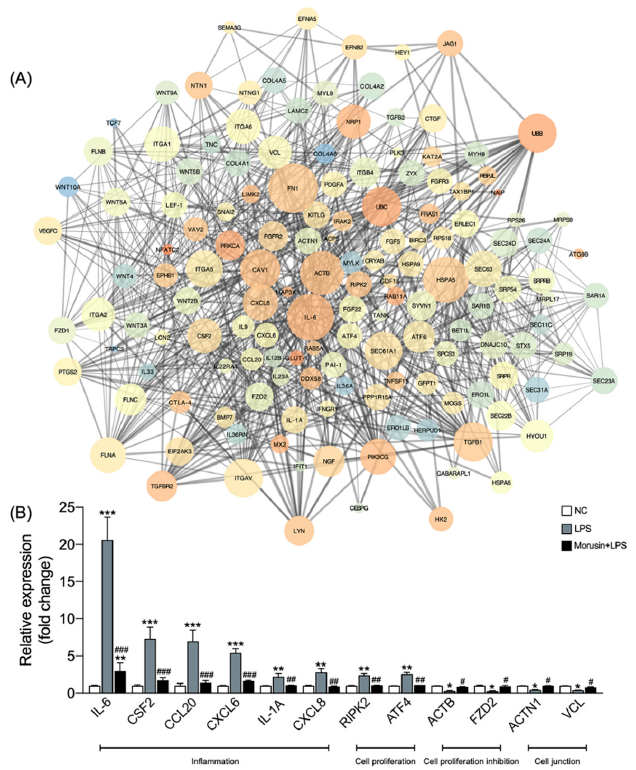
Figure 5. Effects of Morusin on the expression profile of hub genes in ruminal epithelial cells (RECs) with different treatments. ( A ) Protein–protein interaction (PPI) analysis of the overlapping differ- entially expressed genes (DEGs, p adj < 0.05 and fold change > 2) that were downregulated in the Morusin+LPS group compared with LPS group and upregulated in the LPS group compared with NC group, as well as upregulated in the Morusin+LPS group compared with LPS group and down- regulated in the LPS group compared with NC group. The node color represents the clustering co- efficient (low values are blue, and high values are red), and the node size is proportional to the number of degrees. The edge represents the interaction (the thicker edge indicates the lower be- tweenness). ( B ) Expression of representative hub genes related to inflammation, cell proliferation, cell proliferation inhibition, and cell junction in ruminal epithelial cells (RECs) among different groups. RECs were treated without (NC, n = 4) or with 0.1 µg/mL lipopolysaccharide for 3 h after pretreating with 50 µg/mL of Morusin for 12 h (Morusin+LPS, n = 4) or not (LPS, n = 4). Data repre- sent mean ± SEM. * p < 0.05, ** p < 0.01, *** p < 0.001 vs. NC; # p < 0.05, ## p < 0.01, ### p < 0.001 vs. LPS. 2.5. Morusin Inhibited the Activation of AKT and NF- κ B Signaling in RECs upon LPS Stimulation AKT and NF- κ B signaling are known to be key regulators in LPS-induced inflamma- tory responses and abnormal cell proliferation. Therefore, we examined whether Morusin regulated LPS-induced phosphorylation (p) of AKT, I κ B α , and NF- κ B p65 in RECs using immunoblotting. The results showed that the LPS stimulation significantly upregulated the protein expression levels of p-AKT/AKT ( p < 0.05), p-I κ B α /I κ B α ( p < 0.01), and p- p65/p65 ( p < 0.05), while it downregulated the protein expression of I κ B α / β -actin ( p < 0.05) in RECs compared with the negative control. However, the pretreatment of Morusin sig- nificantly downregulated the protein expression levels of p-AKT/AKT ( p < 0.05), p- I κ B α /I κ B α ( p < 0.01), and p-p65/p65 ( p < 0.05) in RECs upon LPS stimulation (Figure 6).